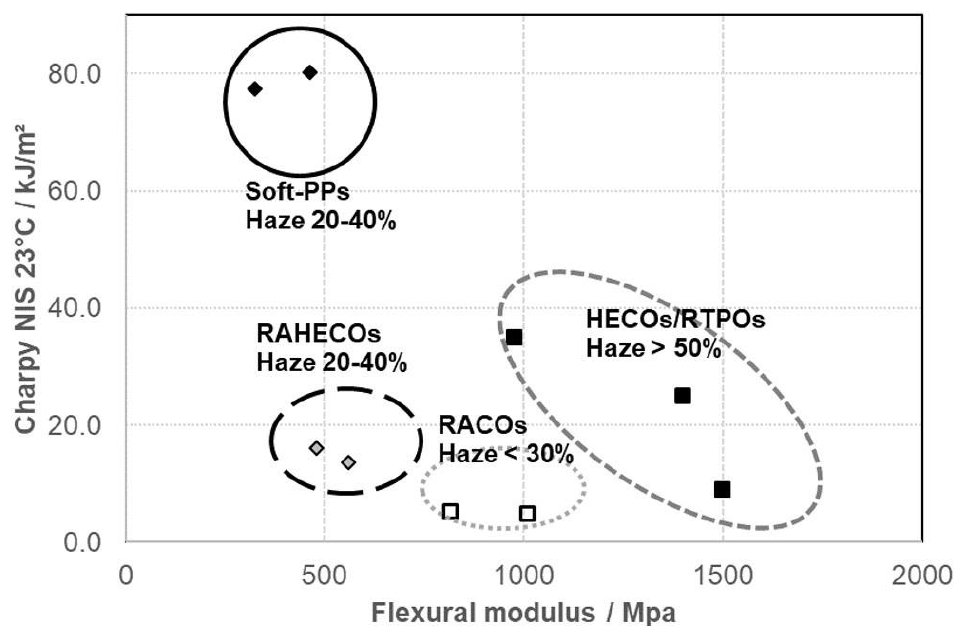
Figure 16. Stiffness/impact balance of different standard and advanced PP copolymers (points correspond to commercial or developmental grades, haze range on 1 mm injection-moulded plaques indicated for each material class).